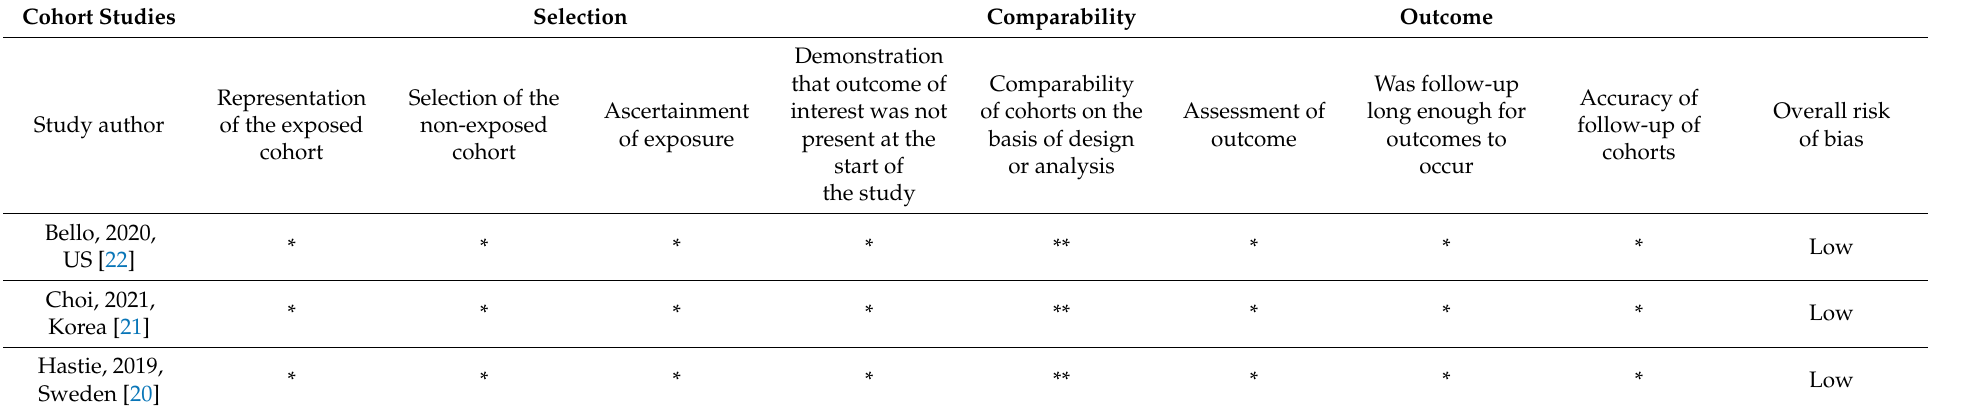
Table 3. Quality assessment of the included